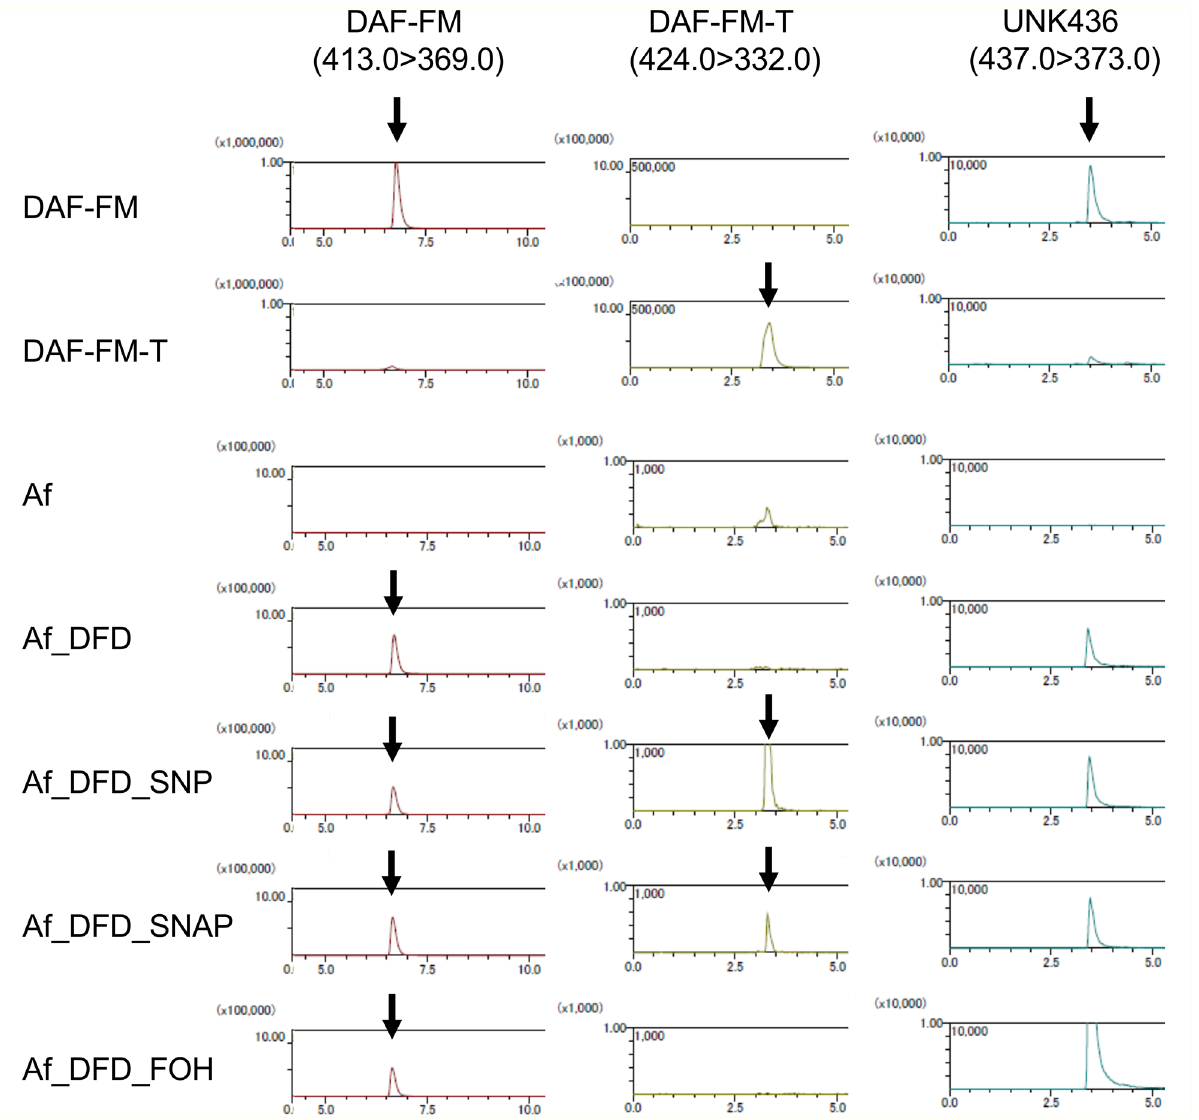
Figure 6. Detection of DAF-FM-T and a DAF-FM-related unknown product. Aspergillus fumigatus was grown in PDB, then supplemented with or without DAF-FM DA (Af or Af_DFD, respectively). DAF-FM DA-treated cells were incubated with sodium nitroprusside (SNP) or S-nitroso-N-acetylpenicillamine (SNAP) as NO donors (Af_DFD_SNP or Af_DFD_SNAP, respectively). DAF-FM-DA-treated cells were incubated with farnesol (Af_DFD_FOH). Each extract was obtained as described for the quantification of DCFH- or DAF-FM- related fluorescence and analysed by LC–MS/MS. DAF-FM was detected with fragments of m/z 413.0 > 369.0, whereas DAF-FM-T was 424.0 > 332.0. The unknown product (UNK436) was detected as the fragment 437.0 > 373.0. As a standard, DAF-FM was incubated with or without SNAP in 10 mM Tris–HCl (pH 7.9) at 37 °C for 60 min (DAF-FM-T or DAF-FM,